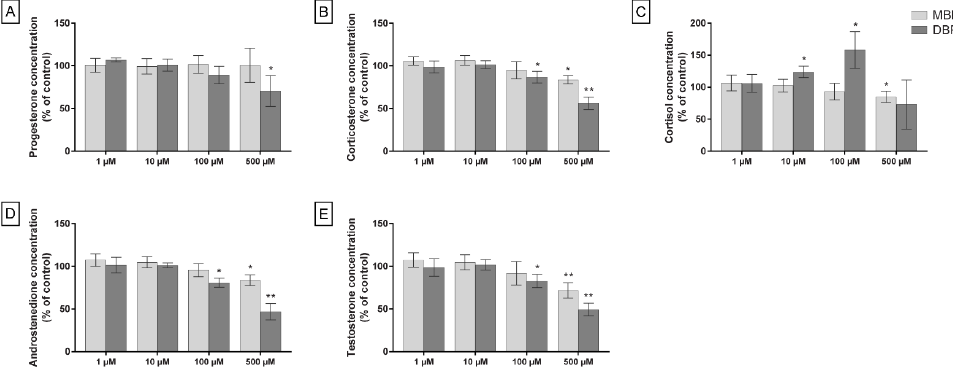
Figure 4. H295R cells exposed to DBP, MBP, or solvent control (0.1% DMSO) for 48 h, with stimulation of the steroidogenesis by 0.1 mM dbcAMP, show altered levels of steroid hormones. Levels of progesterone ( A ), corticosterone ( B ), cortisol ( C ), androstenedione ( D ), and testosterone ( E ) were measured in the cell medium by LC-MS. Values represent mean ± S.D. calculated as % of control for three replicates, where the average of six wells/treatment was calculated for each replicate. Statistically significant differences from a theoretical mean of 100 are indicated as follows: * p < 0.05, ** p < 0.01 (One Sample t -test).